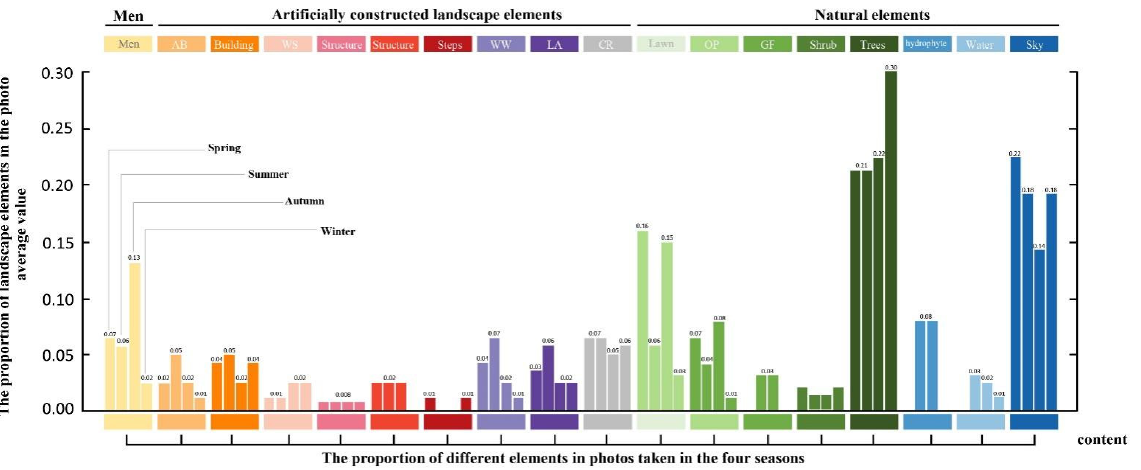
Figure 5. The four seasons focus on landscape elements.